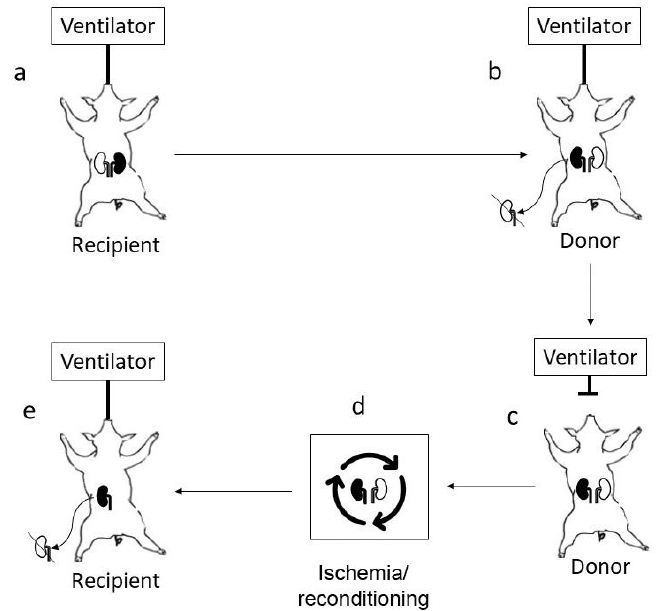
Figure 1. The recipient pig donates the left kidney ( a ) to the right side of the donor pig, after the native right donor kidney ( b ) has been removed. Both kidneys from the donor are then retrieved ( c ) after the donor has been subject to a protocol ischemic event (e.g., cardiac death). The kidneys can be treated ex vivo to recondition the ischemic kidneys ( d ). The recipient pig, that has been kept under anesthesia during the treatment cycle, then receives the original donated left kidney back, transplanted to the right side after the remaining kidney has been removed ( e ). In a sham setting, the recipient pig has the right kidney removed ( a ) and then is kept asleep, remaining under anesthesia for the same time as in the experimental setting, followed by removal of the remaining left kidney and retransplanting it to the right side of the recipient ( e ). The sham pig will experience the same surgical trauma as the study pig.